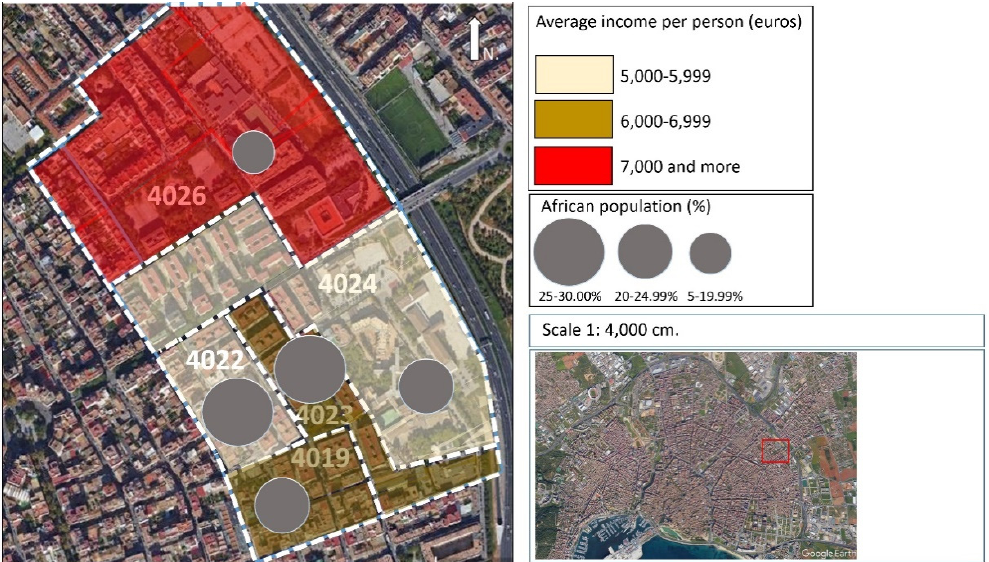
Figure 3. Average per capita income (2017) and percentage of African residents (2019) in Son Gotleu’s census sections. Source: Prepared by the author based on the Municipal Census and Household Income Distribution Atlas